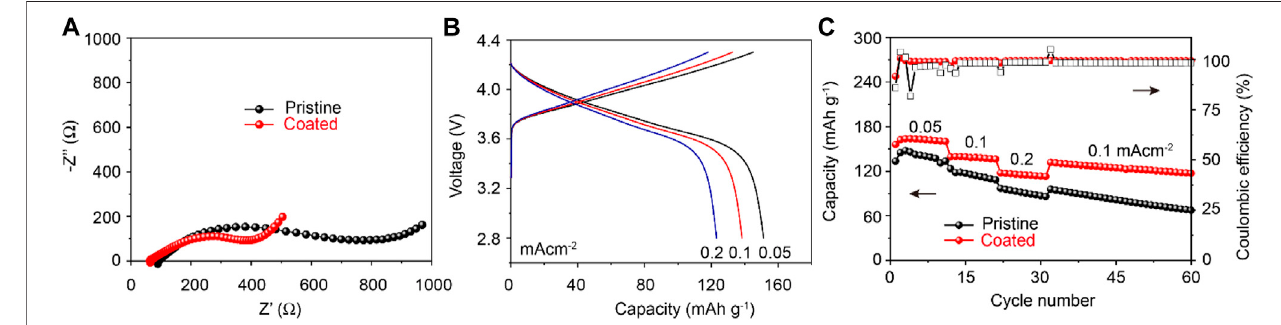
FIGURE 6 | (A) EIS plots of the all – solid – state cells using Li 1.1 Ni 0.35 Mn 0.55 O 2 with/without Li 4 Ti 5 O 12 coating (B) Initial charge and discharge curves of Li 4 Ti 5 O 12 – coated Li 1.1 Ni 0.35 Mn 0.55 O 2 /Li all – solid – state cells (C) Coulombic ef fi ciency and rate performance of all – solid – state batteries using Li 4 Ti 5 O 12 – coated